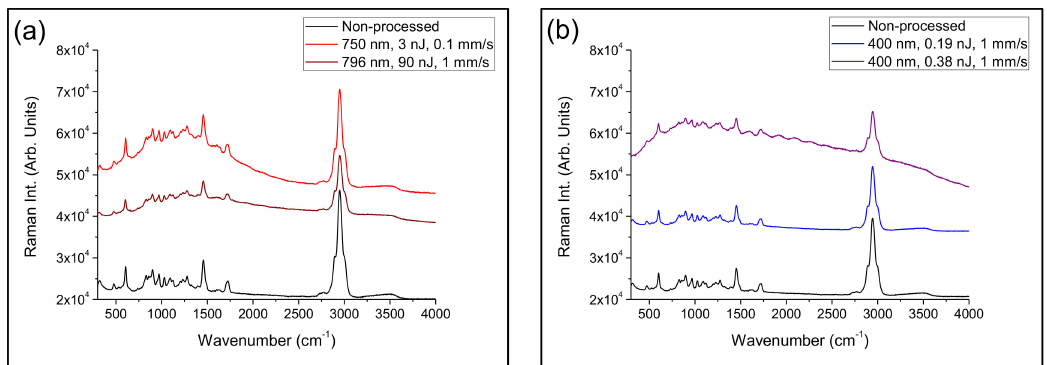
Figure 5. Raman spectra in the wavenumber region 300 − 4000 cm − 1 of non-processed areas and laser-structured regions with the laser amplifier at 796 nm and with the oscillator at 750 nm, ( a ), and with the laser oscillator at 400 nm at high and low laser pulse energy, ( b ).